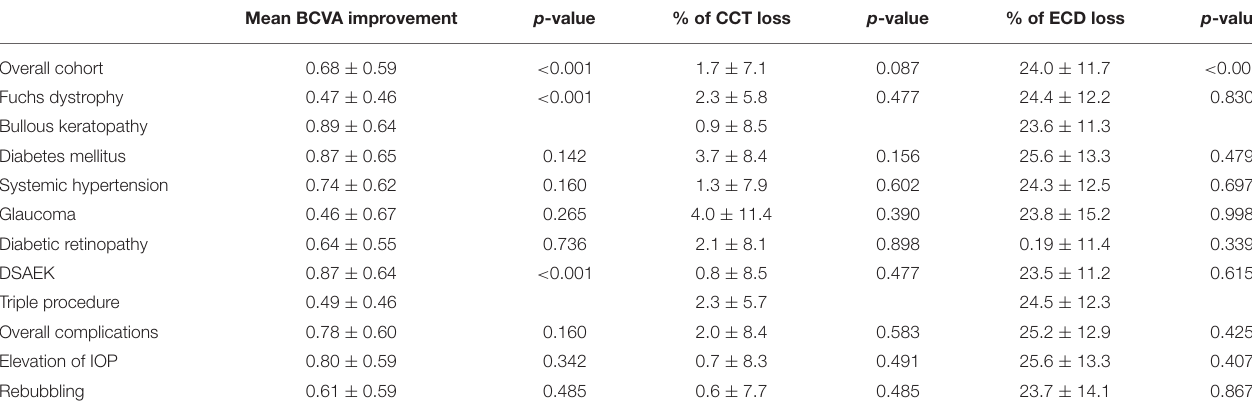
TABLE 3 | Influence of recipient’s factors on BCVA improvement, CCT variation, and ECD loss observed after surgery, measured at last follow-up (mean: 8.58 ± 4.09 months, from 1 to 12 months). Mean BCVA improvement p -value % of CCT loss p -value % of ECD loss p